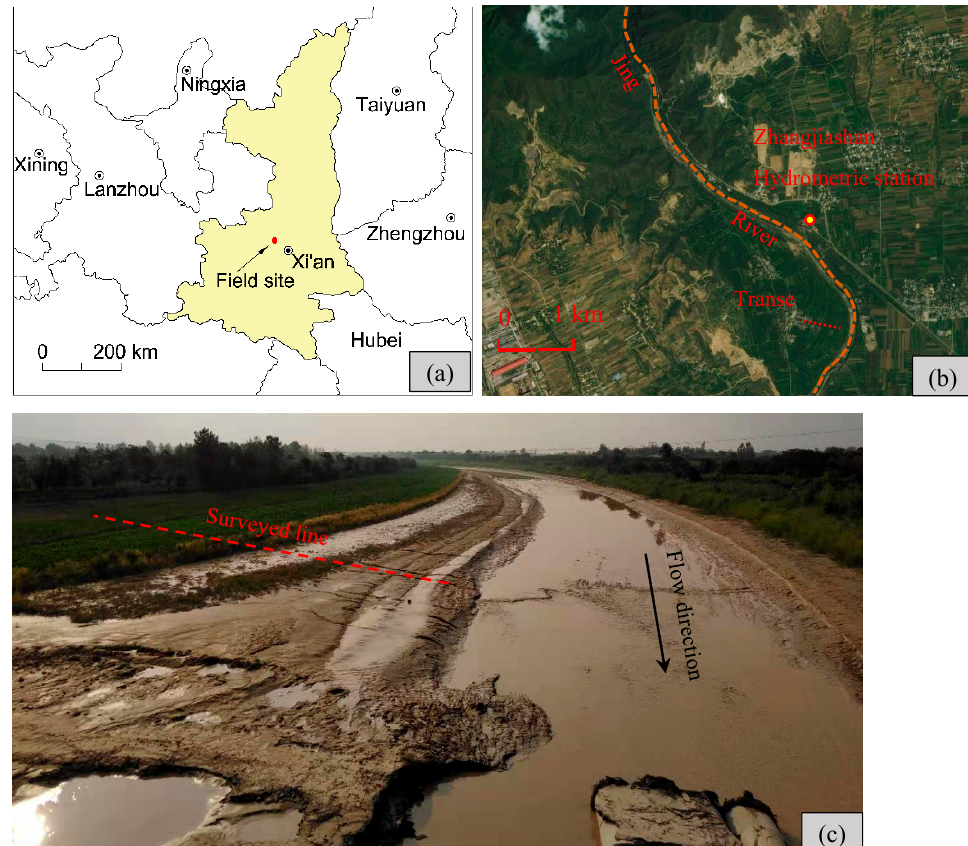
Figure 1. ( a ) Location of the field site near the Jingcun hydrometric station on Jinghe river. ( b ) Satellite images of the field site. The orange dashed line is the Jiang river and the red dashed line is the surveyed line. ( c ) Photograph of the field site; the red dashed line is the surveyed line, along which the slug tests were conducted at different locations.